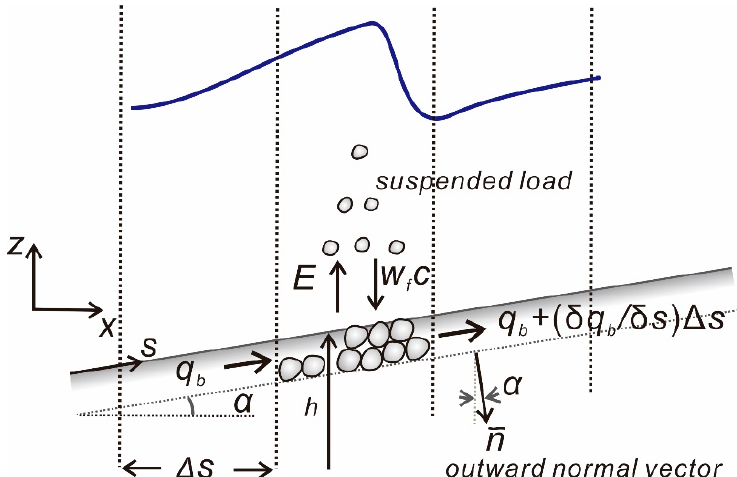
α due to the erosion, and